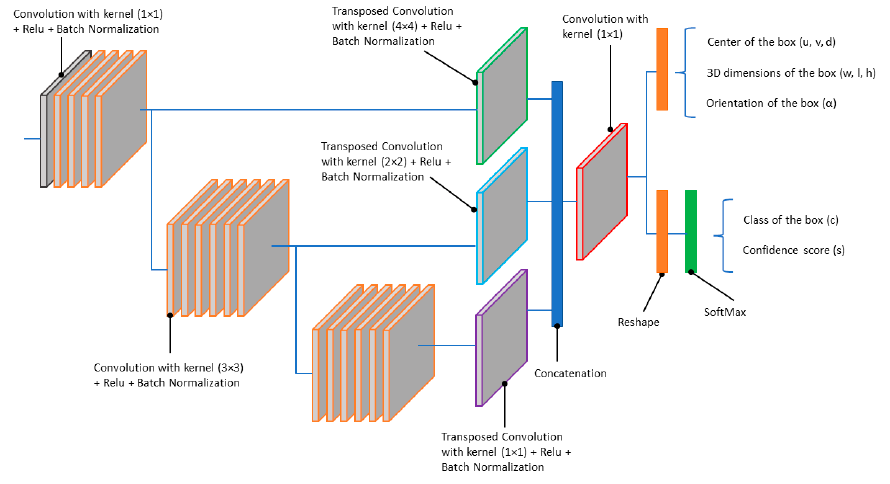
Figure 10. The DCNN architecture.